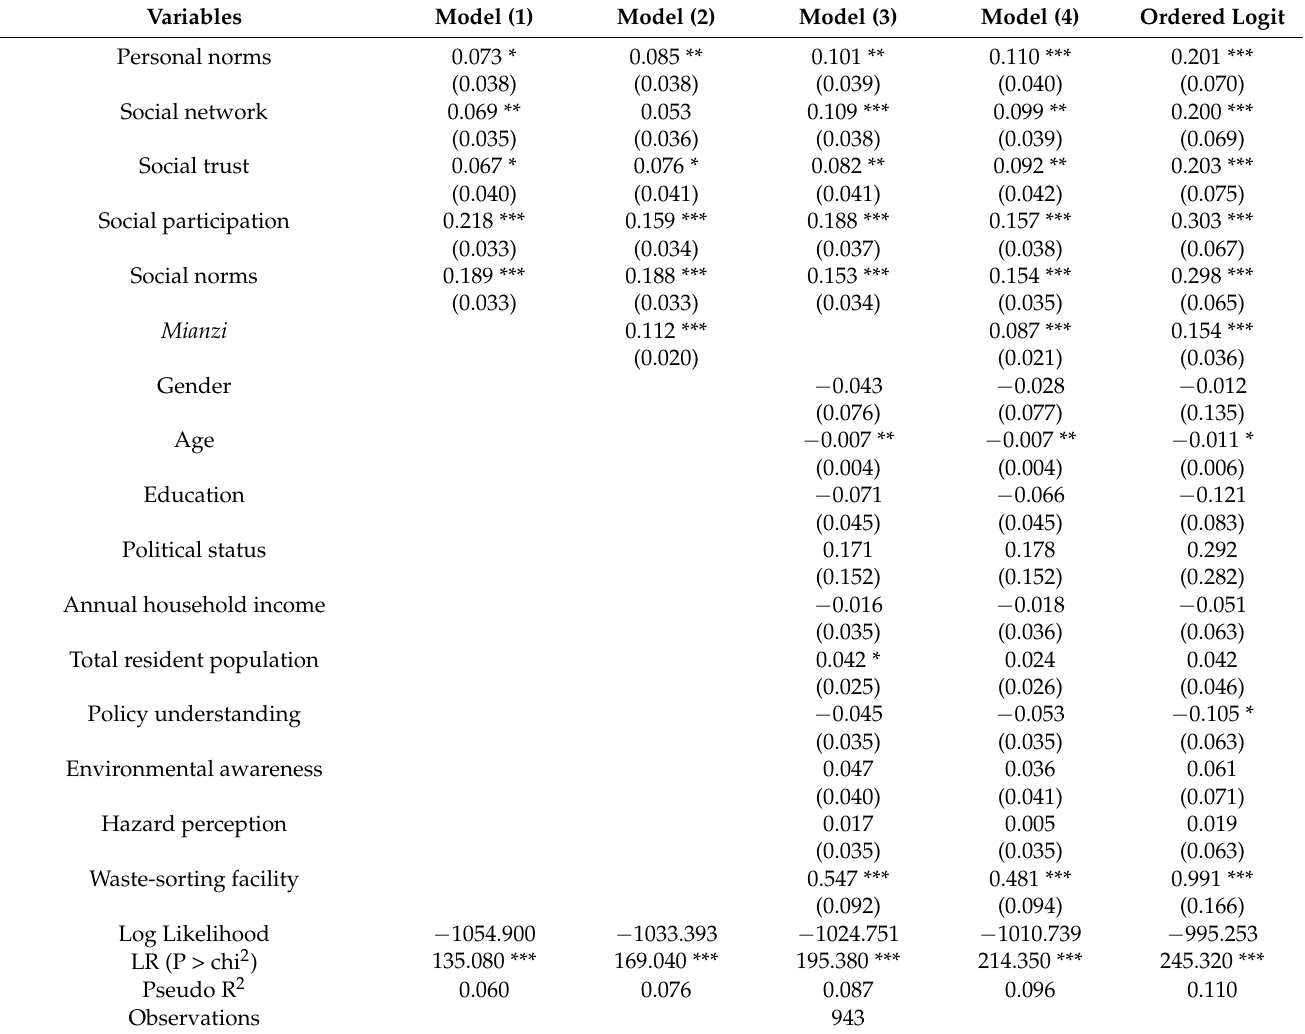
Table 3. Estimation